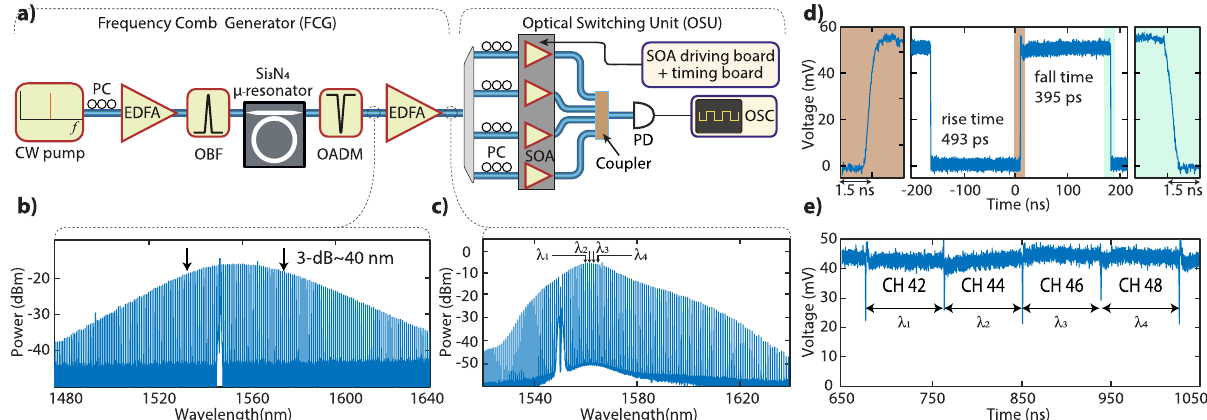
Fig. 2 Experimental demonstration of sub-ns optical circuit switching (OCS) of single and four different microcomb channels. a A packaged Si 3 N 4 microresonator is pumped using a continuous wave (CW) pump ampli fi ed via an erbium-doped fi ber ampli fi er (EDFA) to generate a soliton microcomb. A soliton state is initiated via forward tuning. After fi ltering the pump using an optical add-drop multiplexer (OADM), a low-noise ampli fi er is used to further amplify the soliton comb. The post-ampli fi ed comb is de-multiplexed using a 48-channels 100G AWG, and the individual comb channels are routed to semiconductor ampli fi ers (SOAs) which are controlled via a custom-designed switching board. The output signal is detected using a photodiode (PD) and recorded on an oscilloscope (OSC). PC polarization controller, OBF (narrow) optical bandpass fi lter. b A single soliton spectrum with 3 dB bandwidth around 40 nm and no post ampli fi cation. c Post-ampli fi ed soliton spectrum having maximum power up to − 4 dBm in comb lines close to pump line (1550 nm). d The 10% – 90% rise and fall time of 493 and 395 ps respectively for single comb channel (CH 37: 1554.9 nm). The left and right insets show the zoomed-in view of rising and falling signals. e The four different microcomb channels simultaneously switching at sub-ns time scale with wavelength separation ~4.9 nm. A guard zone of ~2.56 ns is used to allow smooth switching between two adjacent channels. The ER is lower in comparison with ( d ) as signal intensity does not drop to zero while switching between adjacent channels (see “ Methods ” , Switching control unit). CH-42: 1558.988nm, CH-44: 1560.613 nm, CH-46: 1562.238 nm, and CH-48: 1563.863 nm.